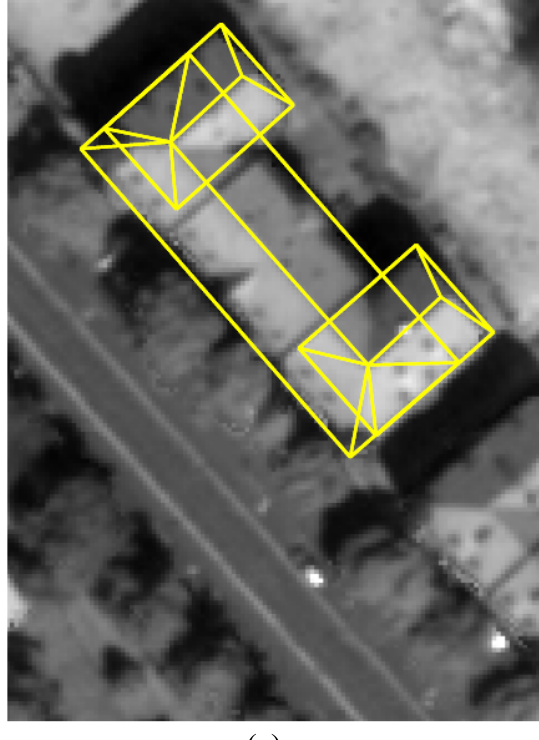
Figure 9 represents the final 3D model of the selected building after refining the polygons plotted on the orthorectified image as well as the DSM. Figure 9. Final model is overlaid on ( a ) orthorectified image and ( b )